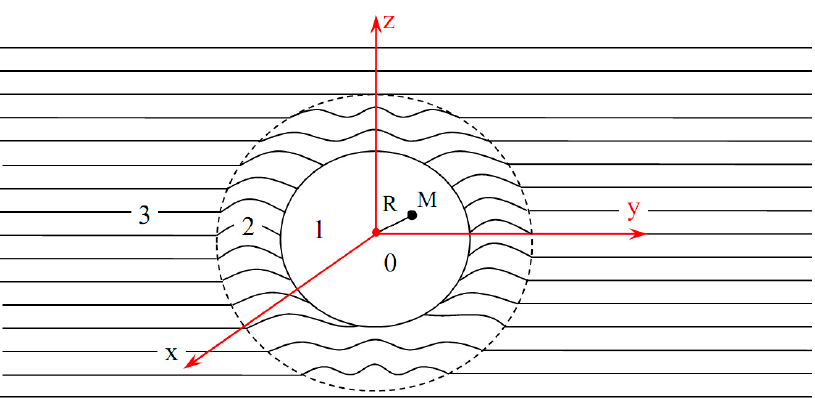
Figure 7. Failure of a nano-structure coating in the area surrounding an embedded droplet.